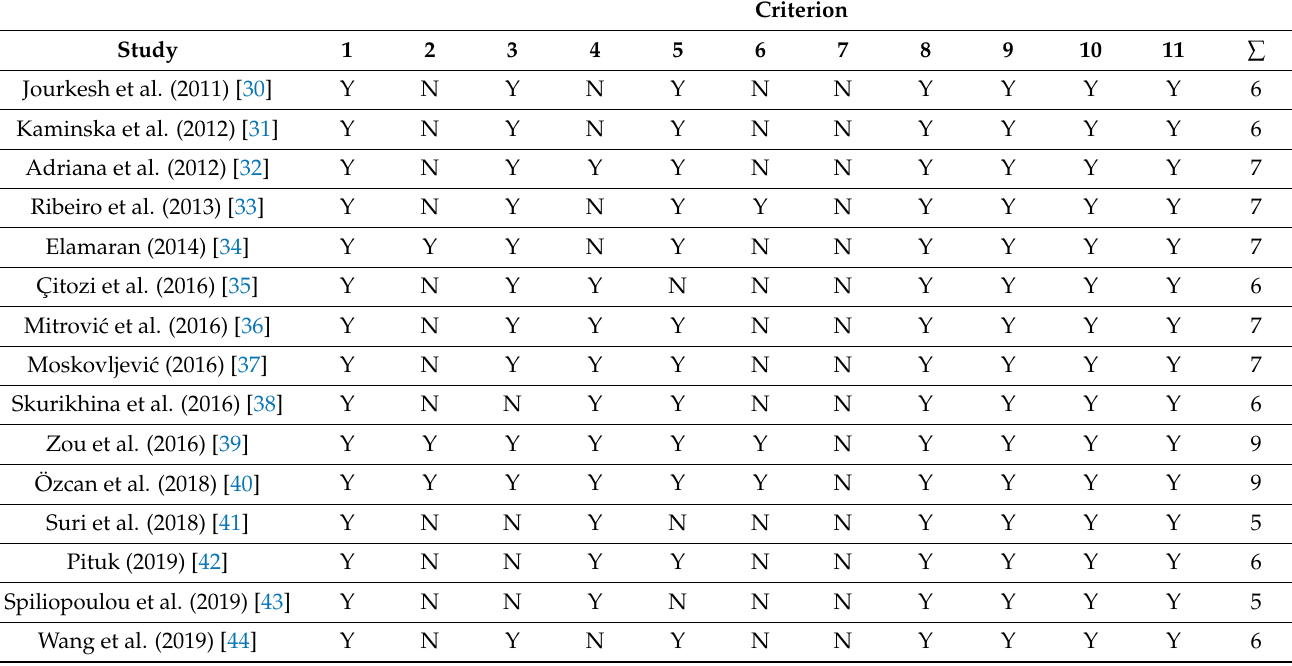
Table 1. PEDro scale